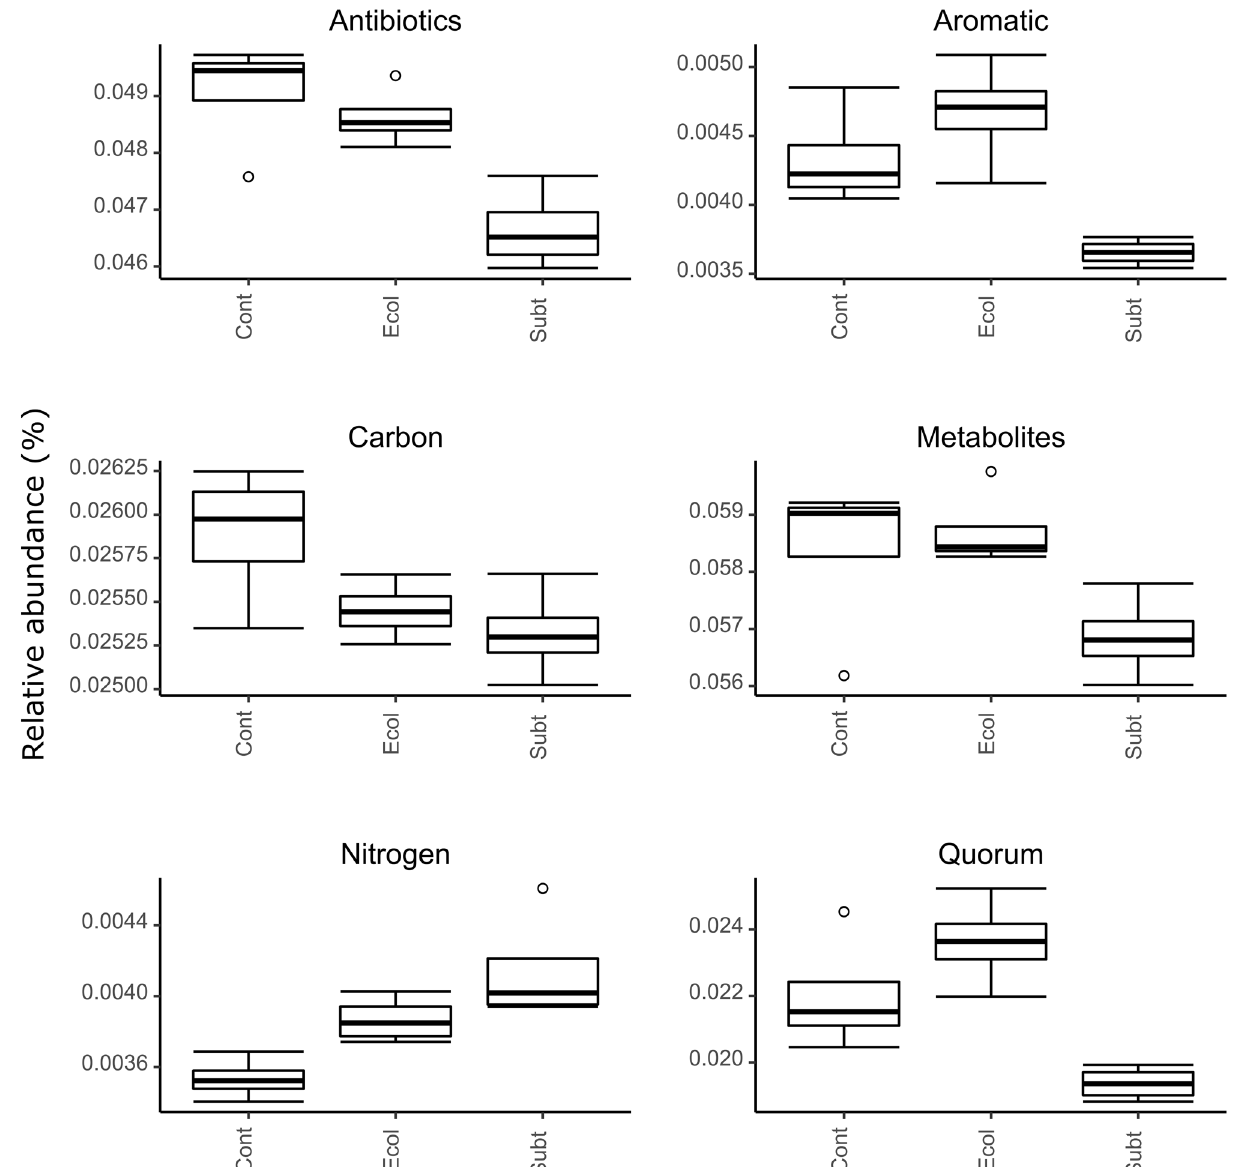
Figure 7. Variation in the relative gene count abundances of selected KEGG level 1 categories: antibiotics: biosynthesis of antibiotics; aromatic: degradation of aromatic compounds; carbon: carbon